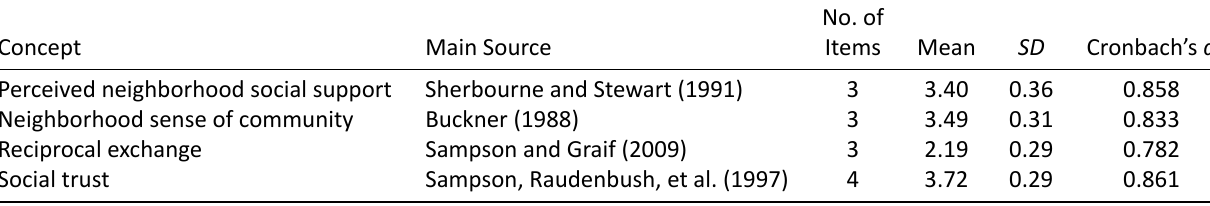
Table 2. Overview of the dependent